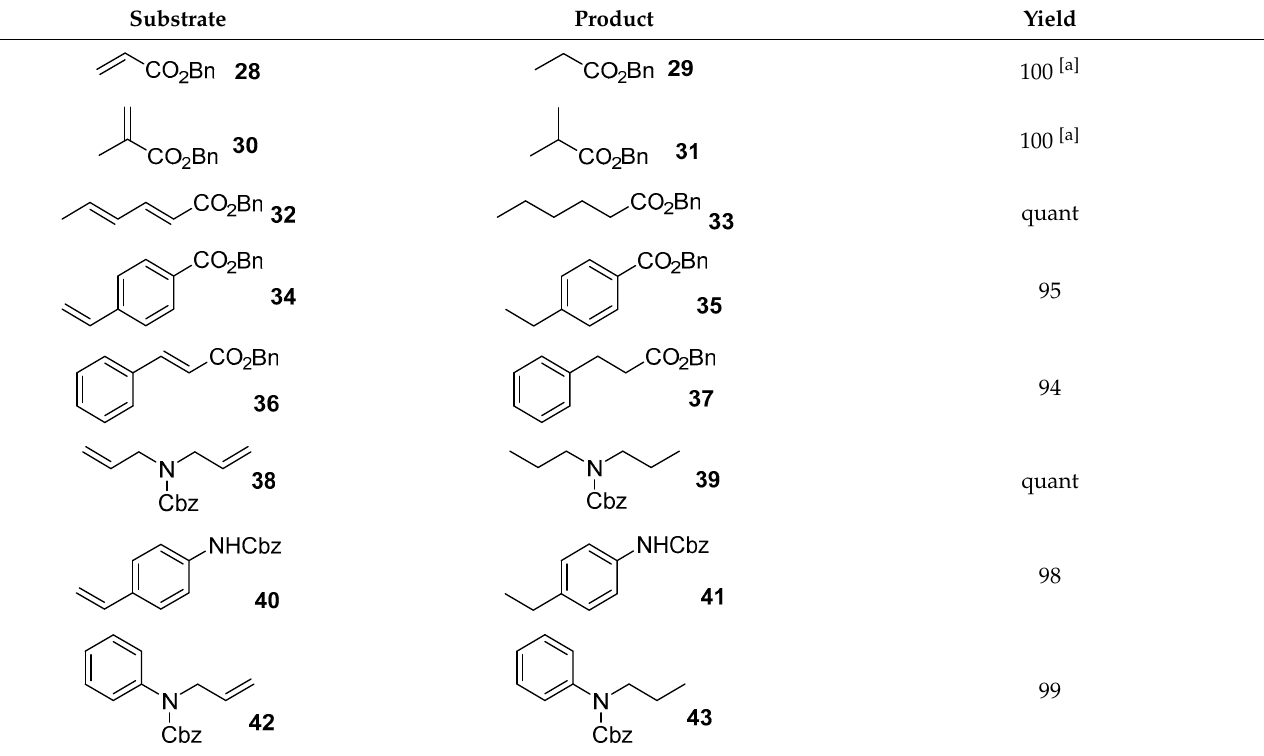
Table 2. Application to Benzyl Ester and N -Cbz Protective Group.